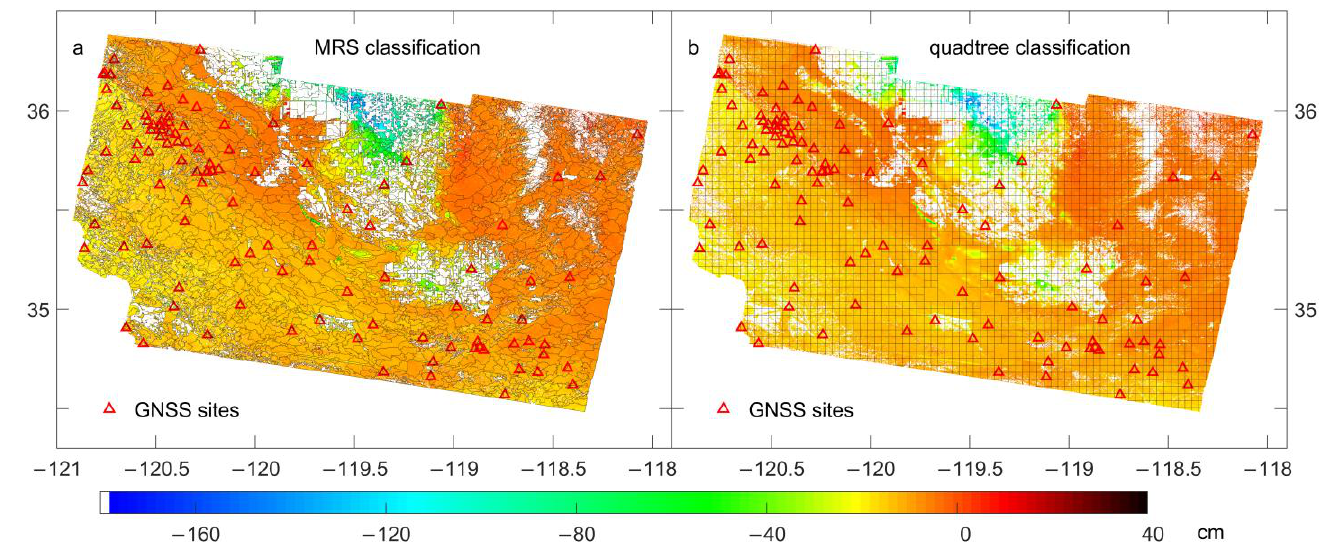
Figure 5. Classification results corresponding to the multiresolution segmentation algorithm ( a ) and quadtree decomposition method ( b ). The grey solid line represents the boundary between different class blocks. Colors represent cumulative displacement values for three periods of interferometric synthetic aperture radar data, warm colors (i.e., positive values) indicate surface displacement towards the satellite, and cold colors (i.e., negative values) indicate motion away from the satellite. Red triangles represent locations of the global navigation satellite system sites.